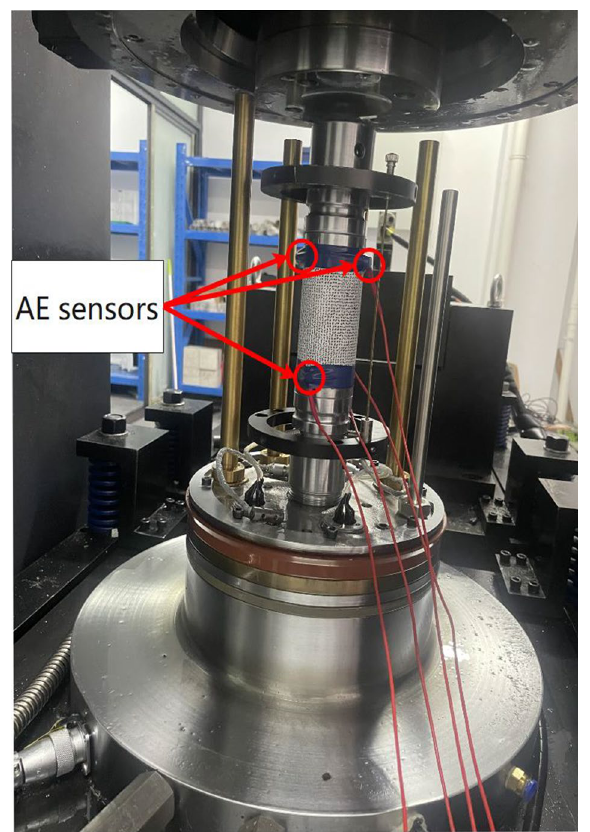
Figure 3. Uniaxial compression test and AE test.